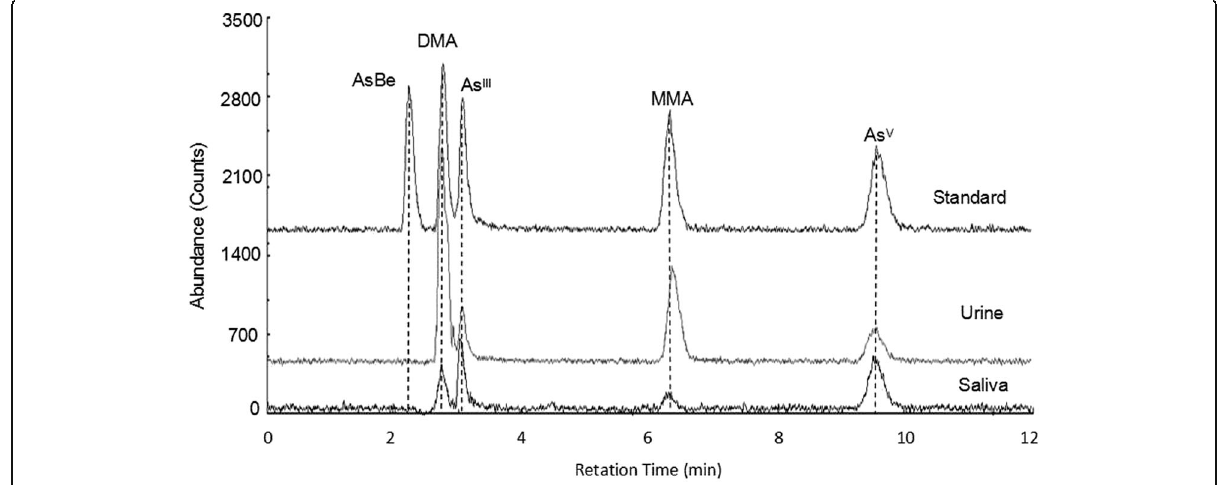
Fig. 2 Chromatograms of arsenic species in the standard solution, urine sample and saliva sample obtained using